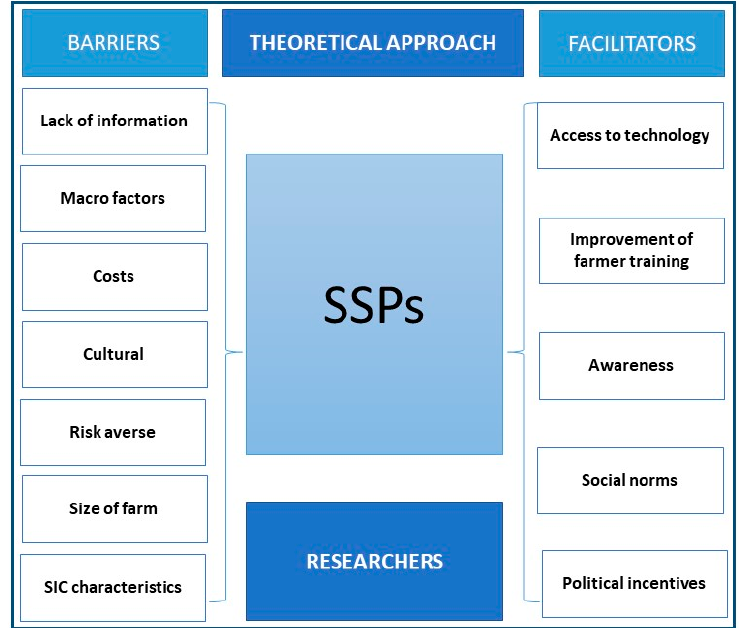
Figure 3. Main barriers and facilitators identified during the first process of interviews.